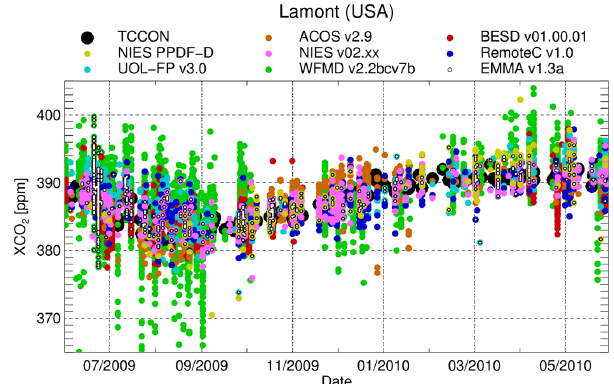
Fig. 1. Co-locations with validation measurements at the TC- CON site Lamont, USA (distance < 500km, time difference < 2h). Soundings included in EMMA are highlighted with a white dot.